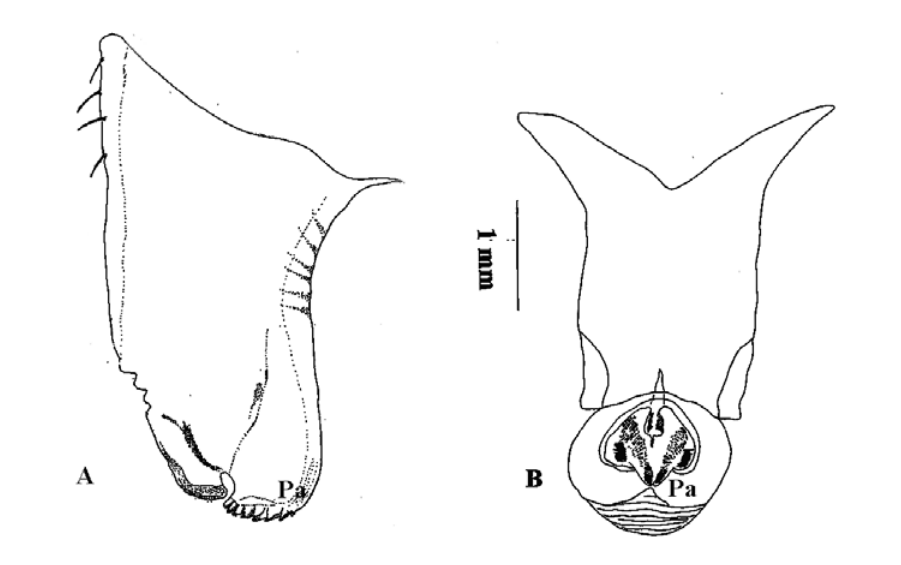
FIG . 10.- Myrmecaelurus trigrammus .male genitalia ,A-lateral view, B-ventral view, pa;